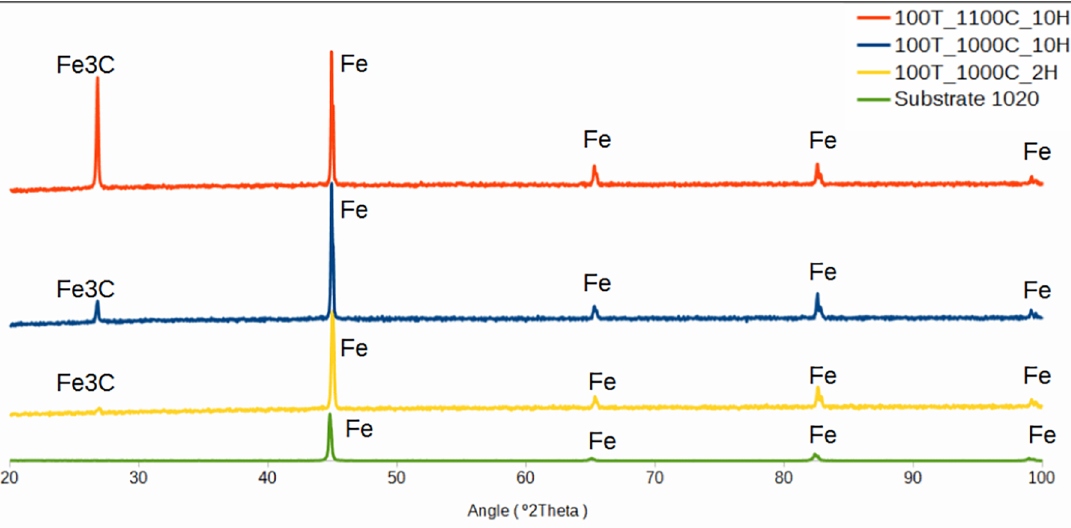
Figure 8. Comparative surface X-ray diffraction patterns of 1020 steel substrate and AISI 1020 steel thermochemically treated with Turbonit ®